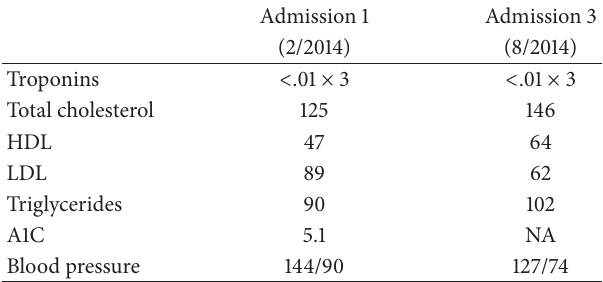
Table 1: Laboratory values and trends for KL’s admissions for unstable